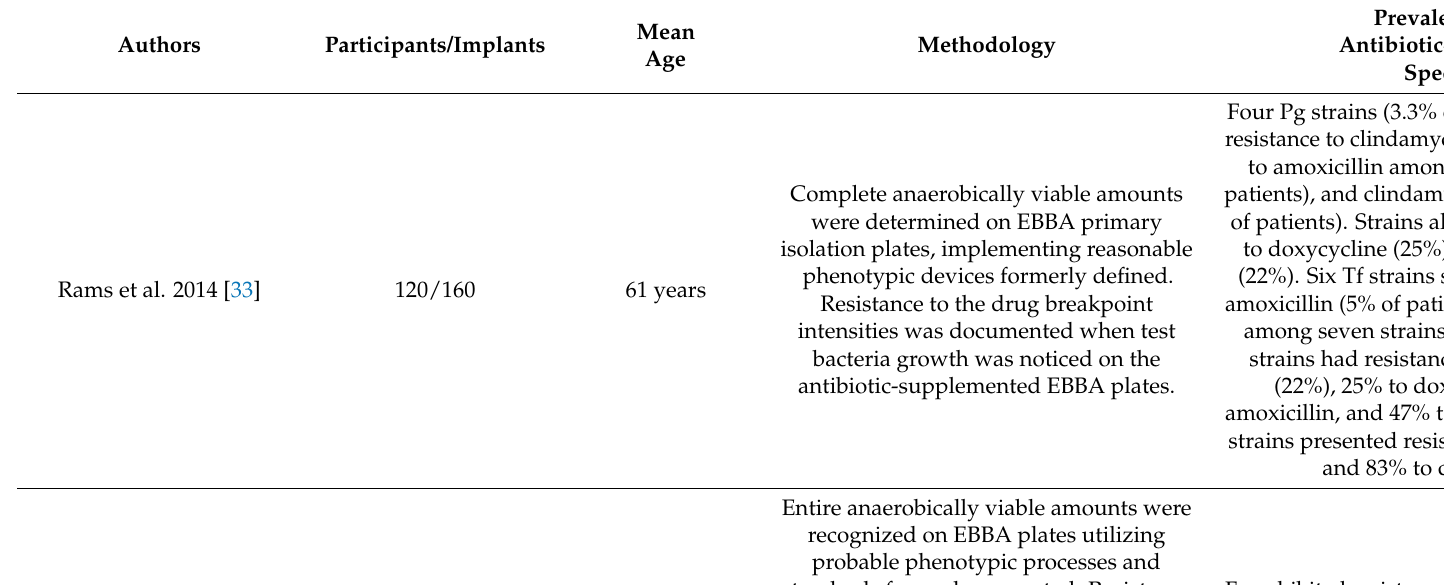
Table 1. Characteristics of the assessed